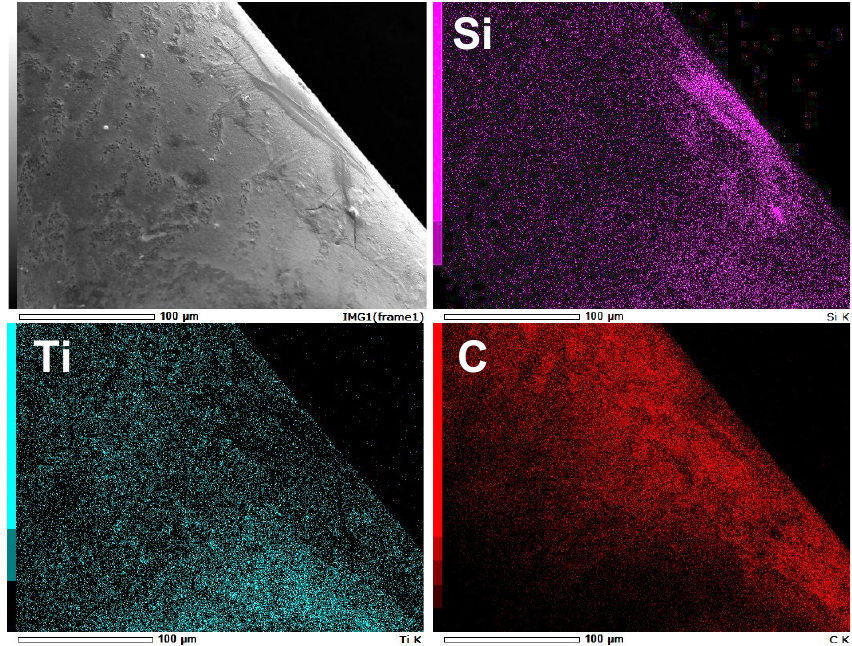
Figure 3. SEM image and EDX elemental mappings of the TiO 2 net.